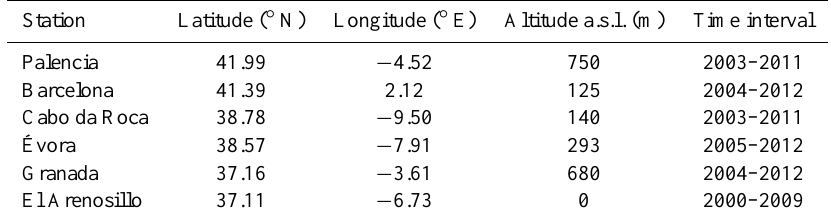
Table 1. Coordinates and time interval of the six AERONET sites used in this study.